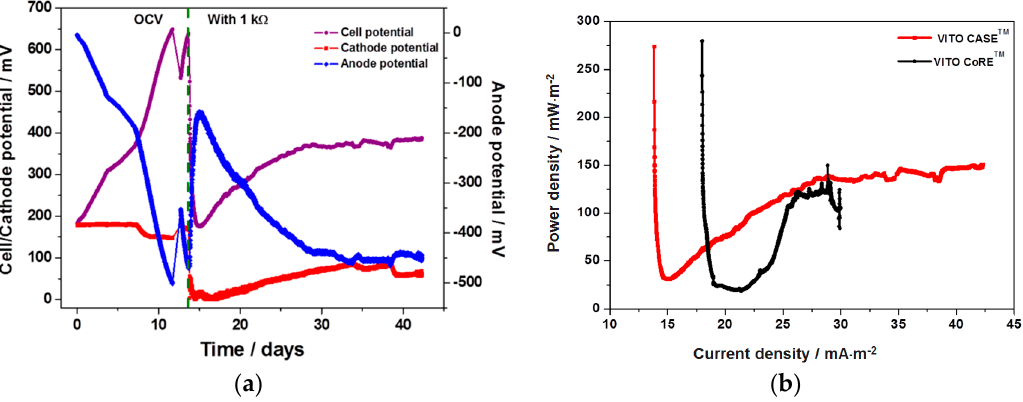
Figure 6. ( a ) Cell potential and anodic, cathodic half-cell potentials against time during MFC operation with VITO CaSE ™ electrode as cathode; ( b ) Comparative power density profiles against time during MFC operation with VITO CoRE ™ and VITO CaSE ™ cathodes.